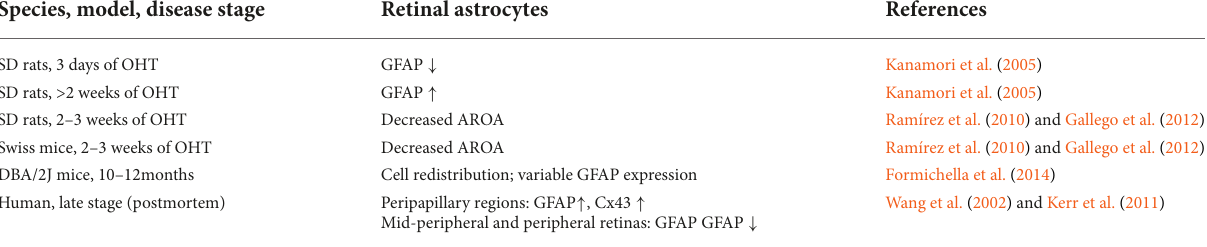
TABLE 2 Retinal astrocytes changes in